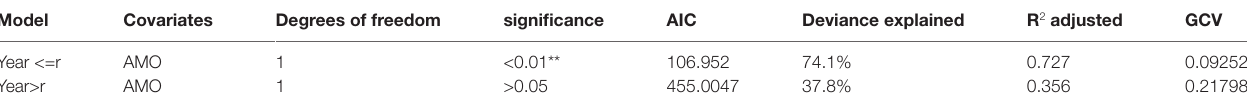
TABLE 2 | Significant covariates degrees of freedom goodness of fit (Akaike Information Criterion, AIC), model performance with deviance explained in percentage and regression coefficient R-sq. adjusted are indicated for identified threshold year GAM models.